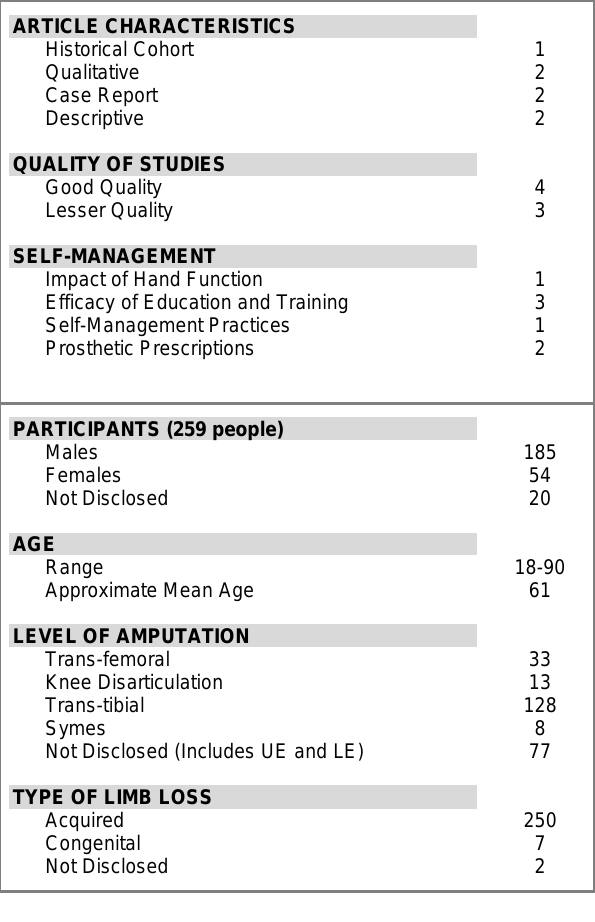
Table 2: Summary of the seven included articles and demographic